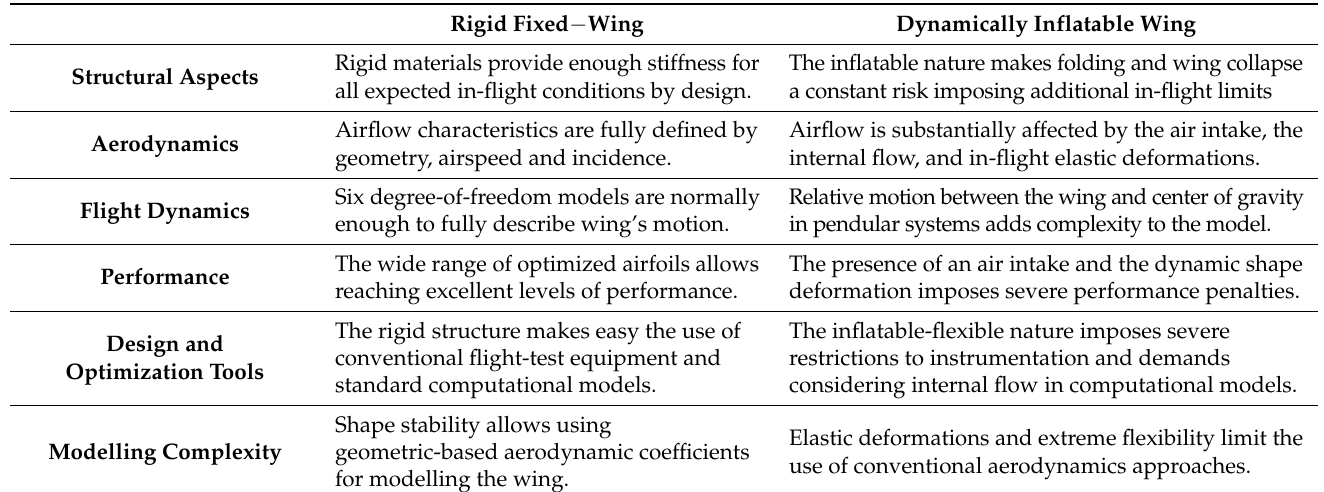
Table 1. Main characteristics differentiating rigid and inflatable